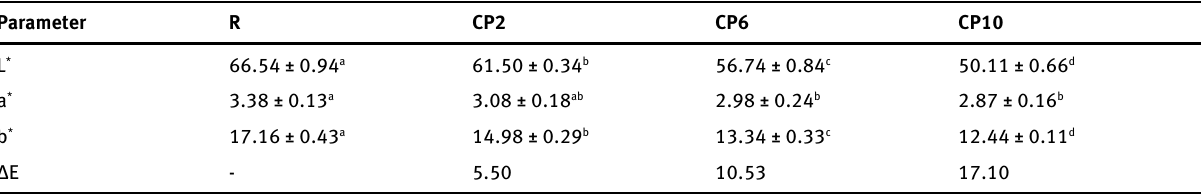
Table 2: Color parameters of pâtés with cricket powder